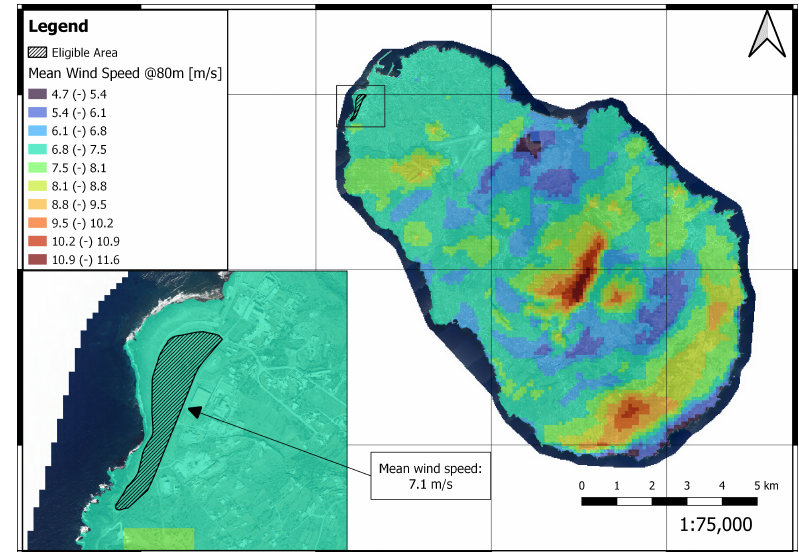
Figure 19. Mean wind speed and suitable